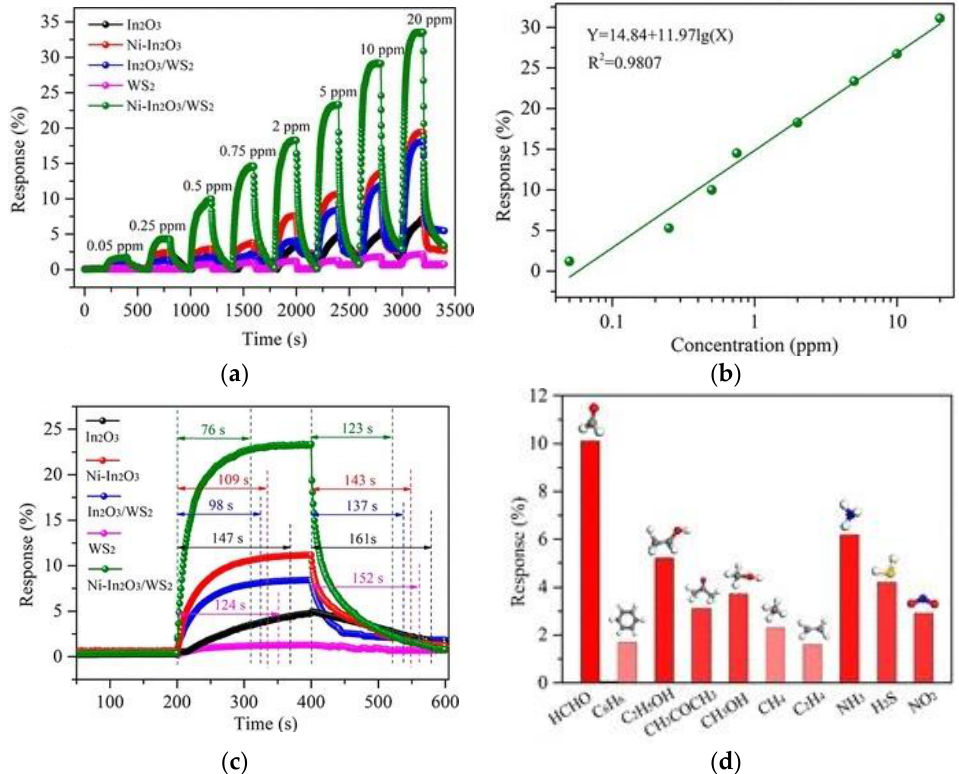
Figure 16. ( a ) Response comparison for the five sensors; ( b ) concentration-response fitting curve of the Ni-In 2 O 3 /WS 2 sensor; ( c ) response and recovery characteristics of the five sensors exposed to 5 ppm formaldehyde; ( d ) selectivity of the Ni-In 2 O 3 /WS 2 sensor [89].